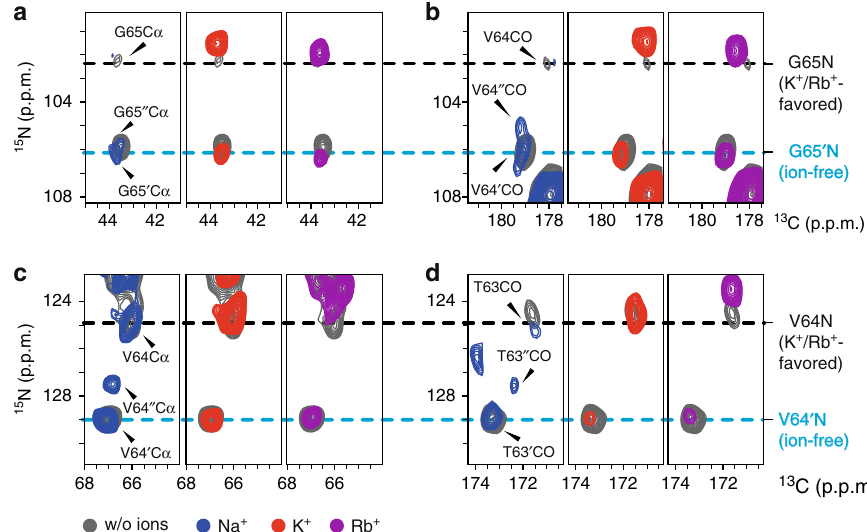
Fig. 2 K + /Rb + -favored and ion-free state observed in ssNMR. Comparison of 2D NCA ( a , c ) and NCO ( b , d ) spectral closeups of SF residues in sample A (<1 µ M ions; gray), B (50 mM Na + ; blue), C (50 mM K + ; red), and D (50 mM Rb + ; purple) states, respectively. Due to comparable rigidity in both conforma- peptide chain, a 15 N – 15 N PDSD spectrum with 5 s mixing time shows a clear cross-peak for T62 ′ – T63 ′ with a similar intensity to the T62 – T63 cross-peak (Supplementary Fig. 7). In an NHHN